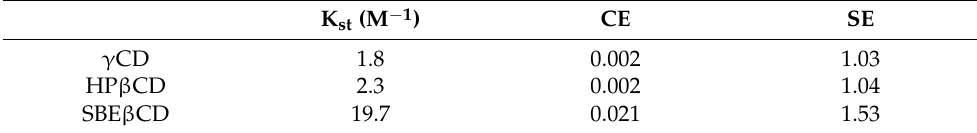
Figure 2. Phase-solubility diagrams of CEF in the presence of increasing concentrations (0–25 mM) of γ CD ( ▲ ), HP β CD ( ♦ ) and SBE β CD ( ■ ) in water at 25 °C. Table 1. Stability constant (K st ), complexation efficiency (CE) and solubilizing efficiency (SE) of CEF complexes with γ CD, HP β CD or SBE β CD in water at 25 ◦